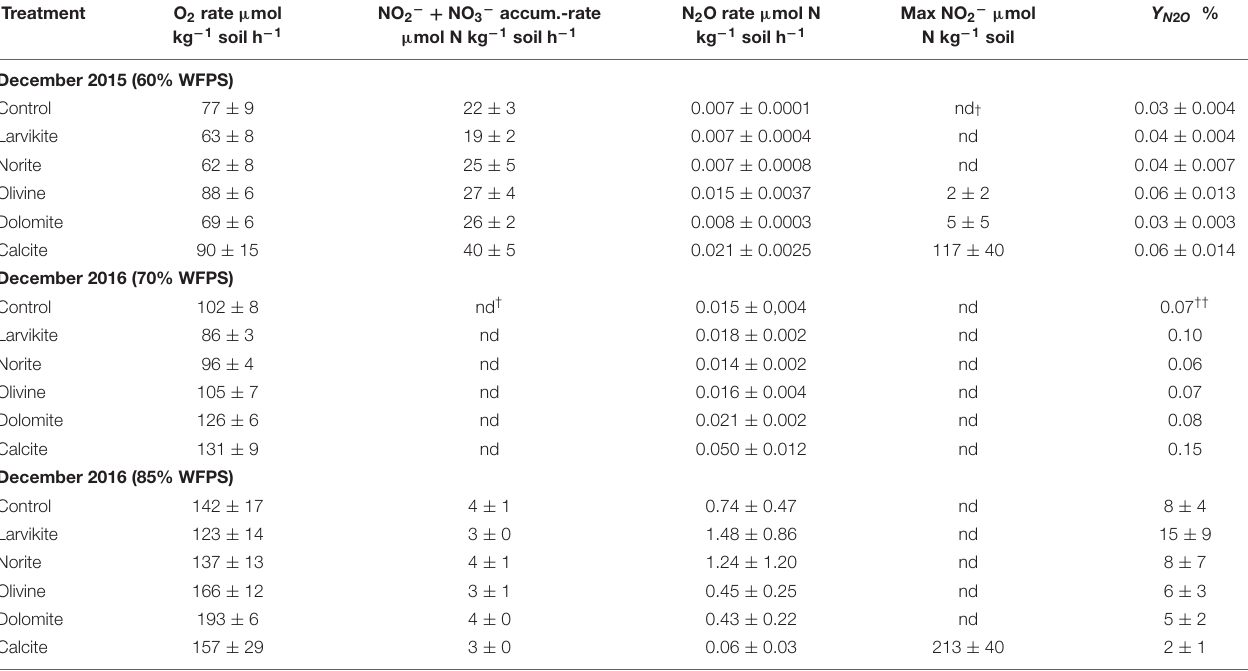
TABLE 5 | Rates of O 2 consumption, net NO 2 − + NO 3 − accumulation, maximum NO 2 − accumulation and N 2 O production rate during oxic incubation of remolded soils amended with ammonium at 60, 70, and 85% WFPS.